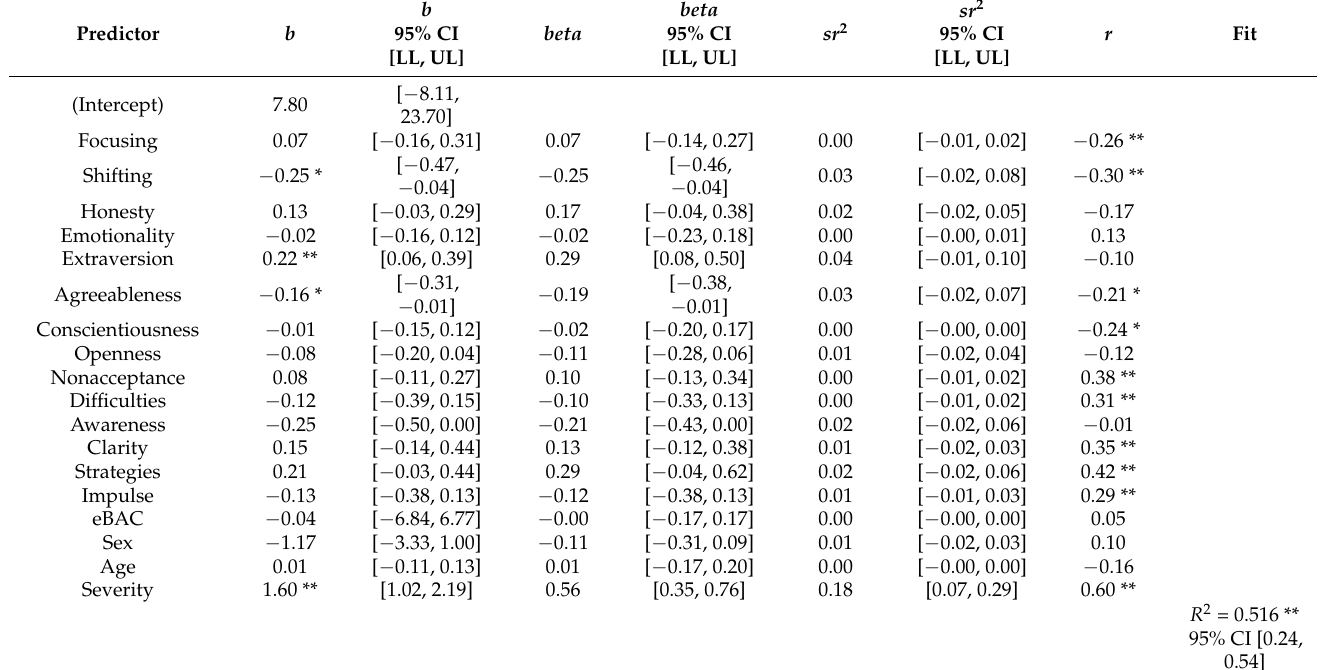
Table 2. Regression results using total impact of hangover scores as the